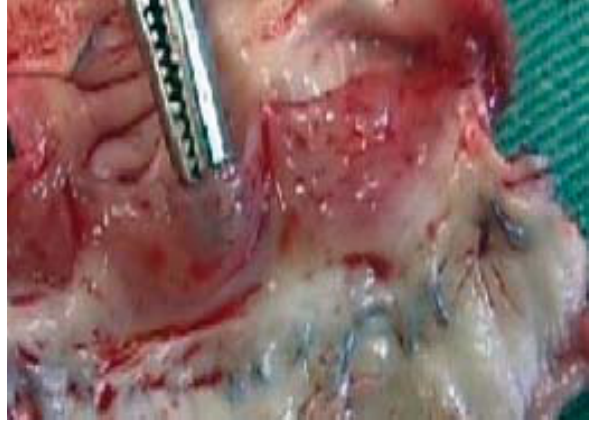
Fig. 1 - Análise macroscópica da cúspide do homoenxerto criopreservado. Foto demonstrando espessamento da cúspide do homoenxerto criopreservado explantado com 9 meses